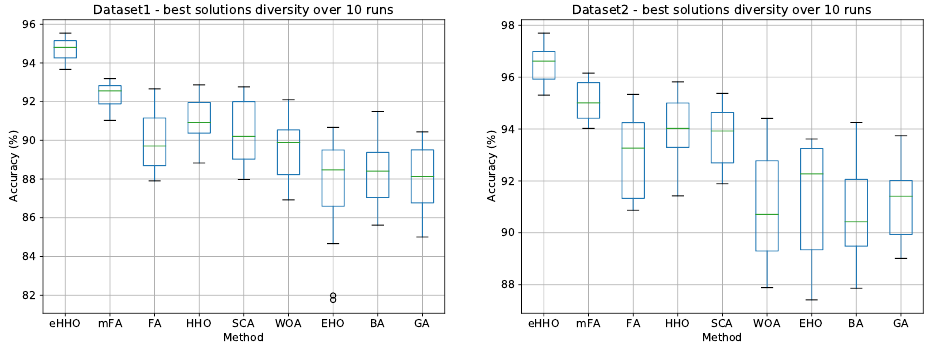
Figure 7. Classification error convergence speed graphs for dataset1 and dataset2 as a direct compar- ison between proposed eHHO and other metaheuristics.